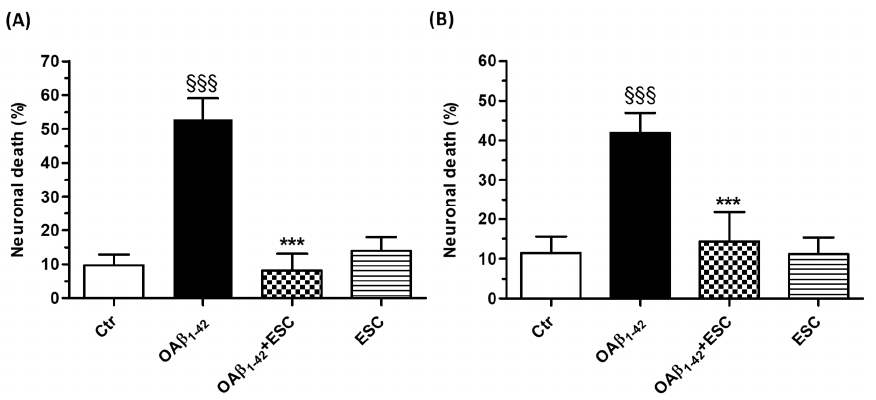
Figure 5. ESC counteracts and prevents the neuronal death induced by OA β 1–42 in SH-SY5Y cells. ( A